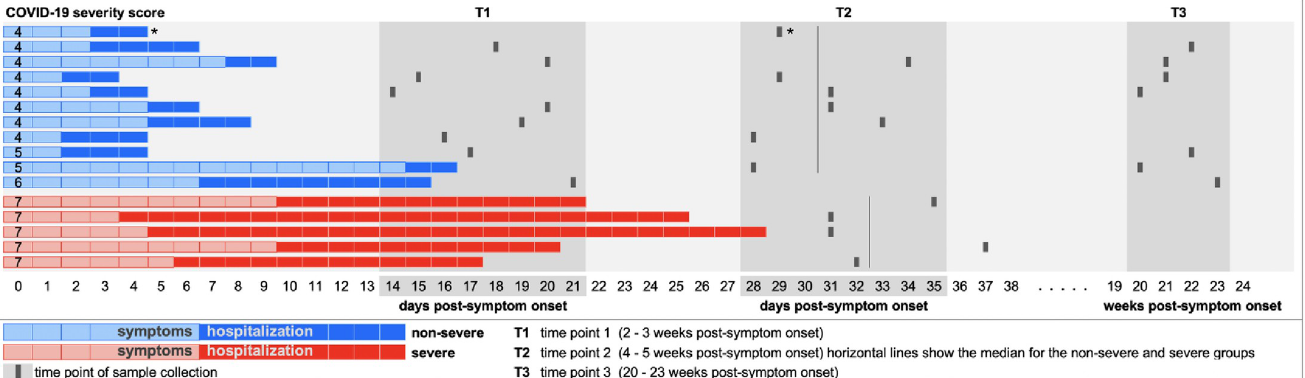
Fig 1. Timing of sample collection. Hospitalized COVID-19 patients were recruited for the study and sampled after hospital discharge. Samples from T2 were used for the comparison of B cell responses between individuals who recovered from non-severe and severe COVID-19 (Figs 2–4). All samples at T2 were collected 4–5 weeks post-symptom onset (PSO), with the exception of one severe donor who was sampled just after 5 weeks PSO (37 days). Longitudinal analysis of samples collected at T1 –T3 could only be performed for individuals who experienced non-severe disease, because the majority of severe patients were still hospitalized at T1 and we were unsuccessful in recruiting recovered severe patients for a follow-up blood draw at T3. The donor marked with � was included in the analysis of B cell subsets (Fig 2) and the percentage of spike-specific B cells (Fig 3C), but could not be included in all subsequent analyses because only a small number of spike-specific B cells (n = 6) was detected in this